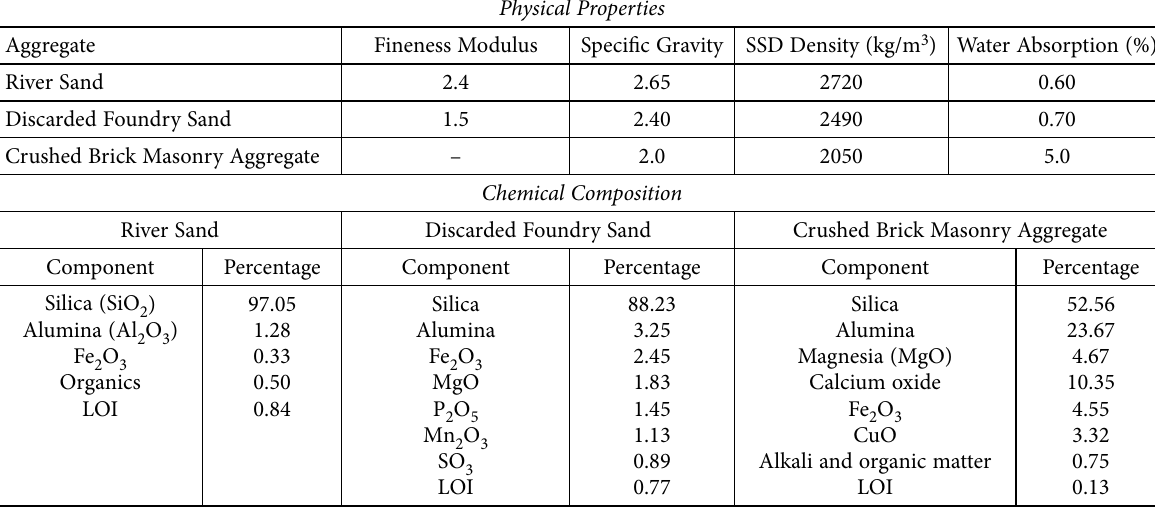
Table 2. Physical properties and chemical composition of aggregates Physical